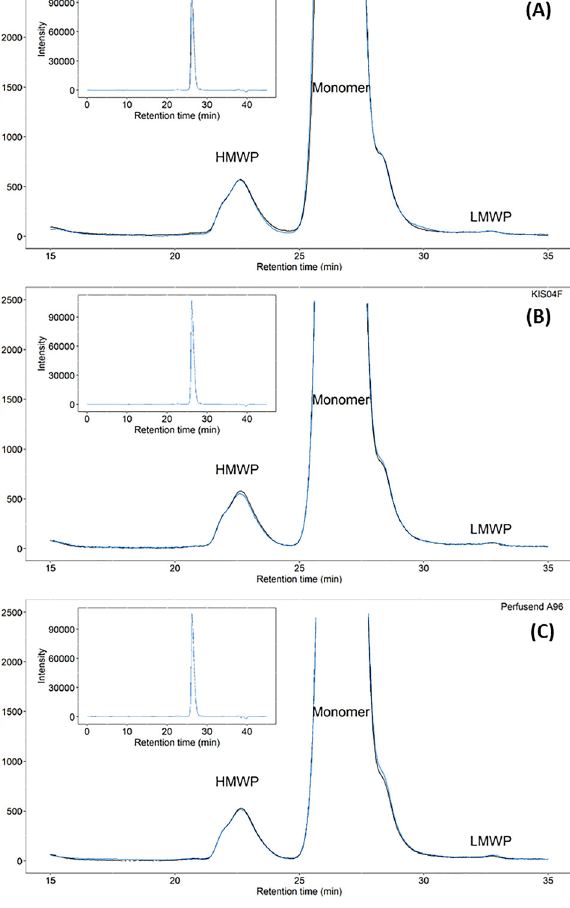
Figure 3: Sixe exclusion chromatograms of 0.4 mg/mL in fl iximab solutions before (black curve) and after (blue curve) a 2-h infusion through the studied infusion sets: V86 IV Star (A), KIS04F (B) and Perfusend A96 (C). HMWP: High Molecular Weight Product; LMWP: Low Molecular Weight